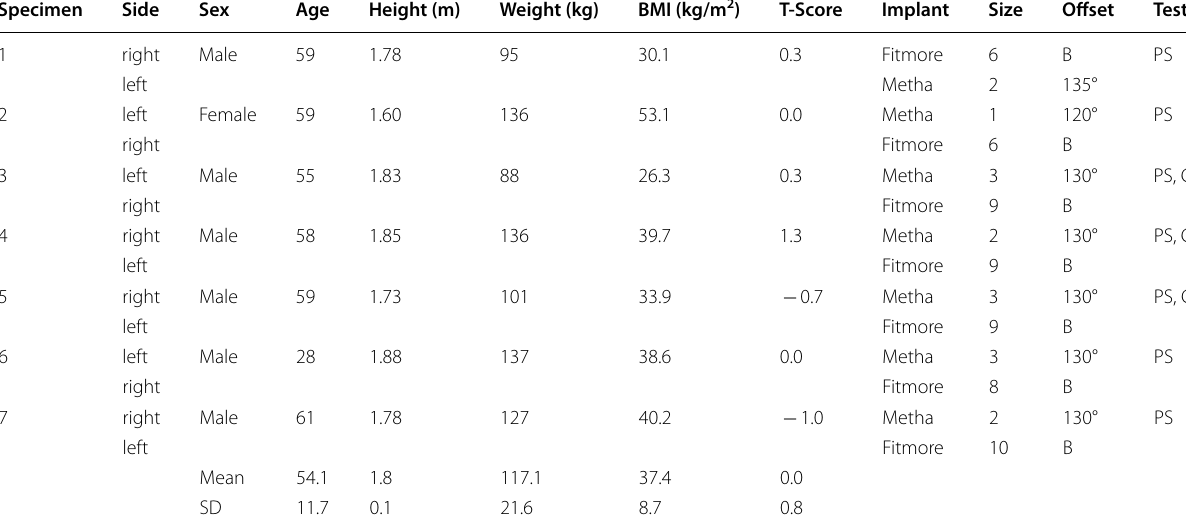
Table 1 Demographics of the donors (PS: Primary stability, CS: Cortical strain measurement)